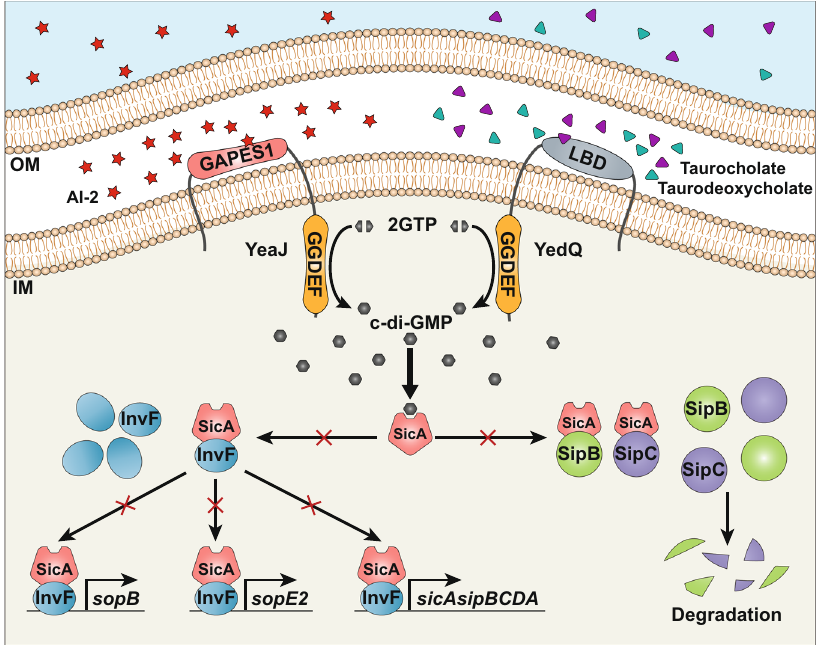
Fig. 6 | Model of how AI-2 and bile stimulate the synthesis of c-di-GMP to represstheT3SSthroughtargetingtheCesD/SycD/LcrHfamilyofchaperones. The QS signal AI-2 and host-derived cues, including bile components taurocholate andtaurodeoxycholateinduceanincreaseinintracellularc-di-GMPconcentrations via the DGCs YeaJ and YedQ, respectively. When the intracellular c-di-GMP level is